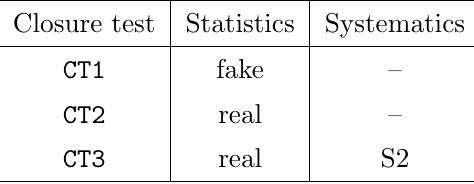
Table 2 . Closure tests with di(cid:11)erent choices of the statistical and systematic error. The results for each option above is summarised in the plots below.